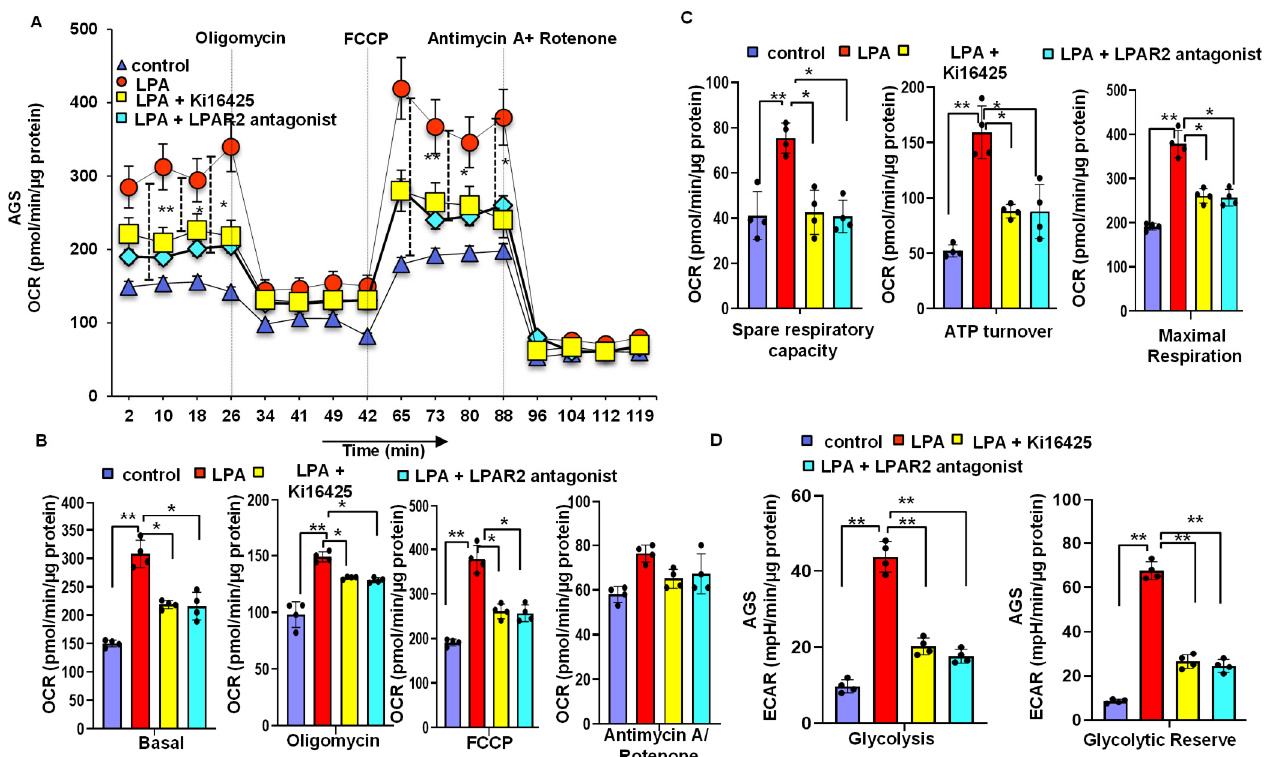
Figure 5. LPA treatment stimulates cellular energy metabolism through the LPAR2 receptor. ( A , B ) Representative graphs and quantification of OCR measurement in control (no LPA), LPA-treated, LPA + Ki16425, or LPA + LPAR2 antagonist-treated AGS cells showing basal OCR and after sequential addition of oligomycin, FCCP, and antimycin + rotenone. ( C ) Quantification of spare respiratory capacity, ATP turnover, and maximal respiration after treating the AGS cells with control (no LPA), 10 µ M LPA, LPA + Ki16425, or LPA+ LPAR2 antagonist. ( D ) ECAR analysis of the AGS antagonist. The bar graphs represent glycolysis and glycolytic reserve. All values are mean ± SD ( n = 5). * p < 0.05, ** p < 0.01 compared to the control. Student’s t -test was used for comparisons between two groups; one-way ANOVA followed by the Bonferroni post hoc test was performed for more than two